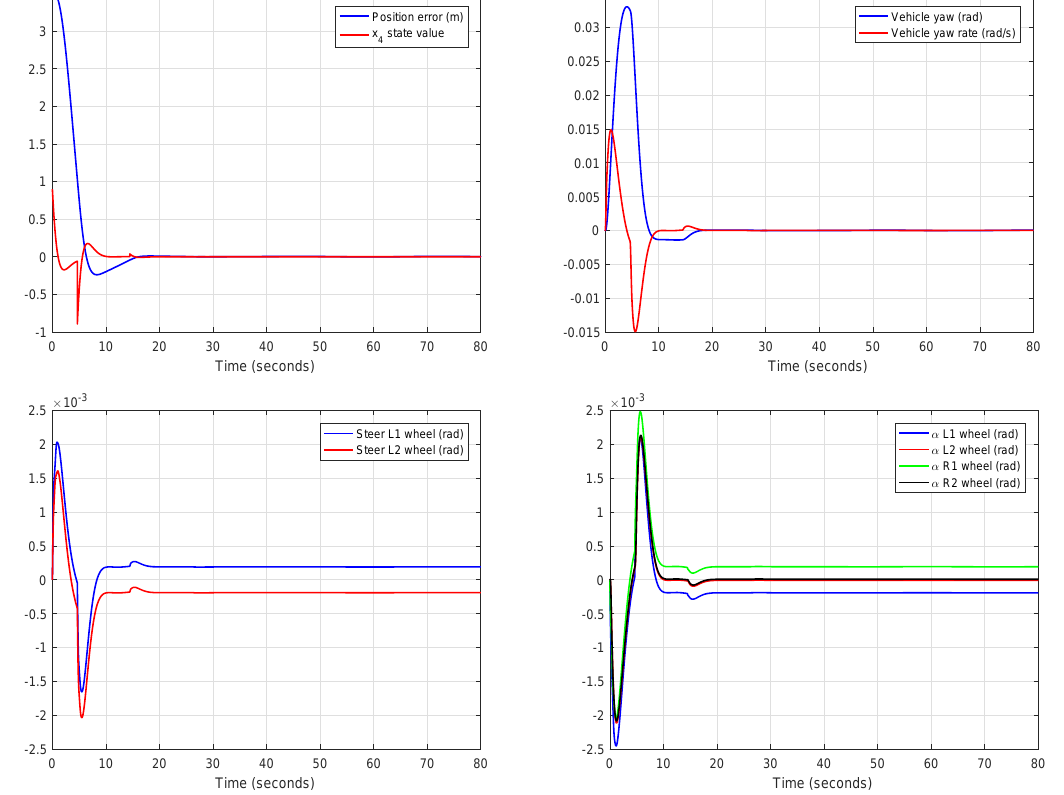
Figure 29. Detail of the experiment for the controller with variable band and optimal reset in